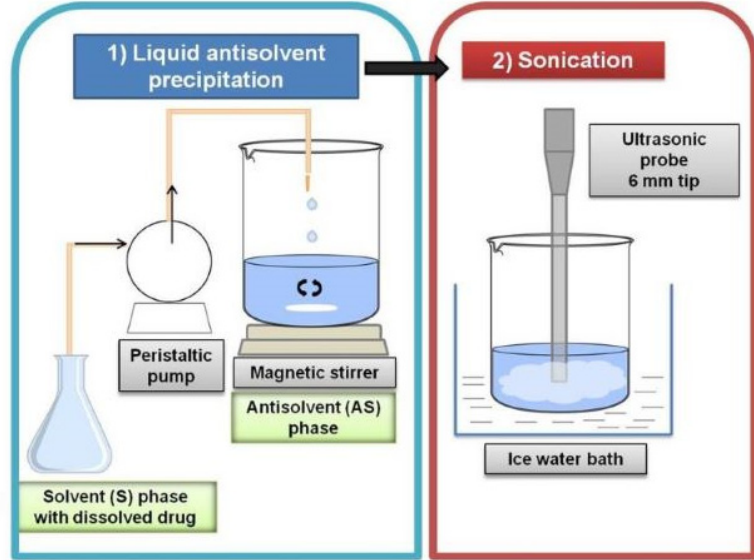
Figure 1. ( A ) A flowchart overview of the systematic approach in the current work. ( B ) A schematic diagram of liquid antisolvent precipitation and sonication process.